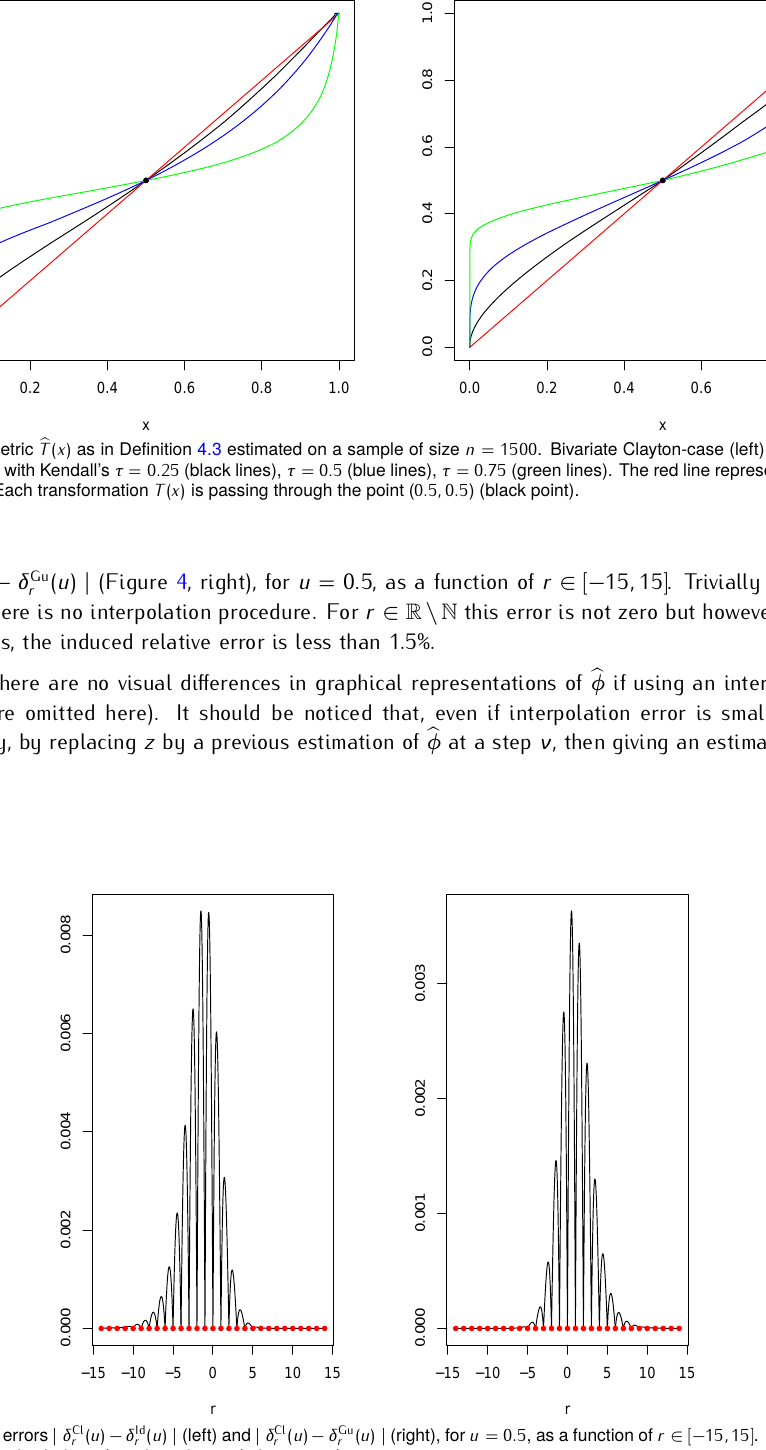
Figure 4. Theoretical errors | δ Cl r ( u ) −δ Id r ( u ) | (left) and | δ Cl r ( u ) −δ Gu r ( u ) | (right), for u = 0 . 5 , as a function of r ∈ [ − 15 , 15] . For r = k ∈ is null (red points) since there is no interpolation